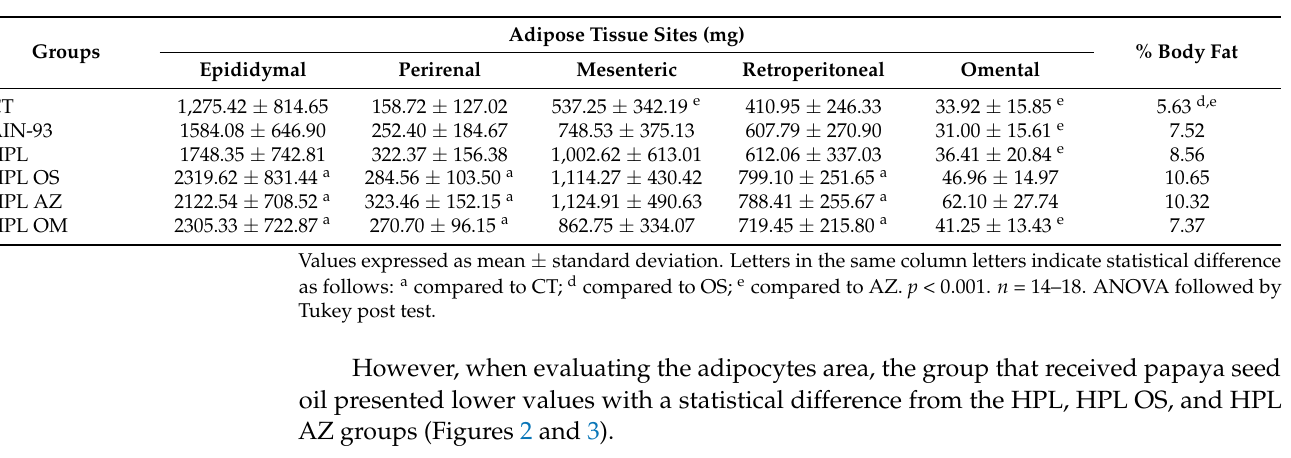
Table 3. Weight of adipose tissue sites and percentage of body fat of animals fed a balanced or high-fat